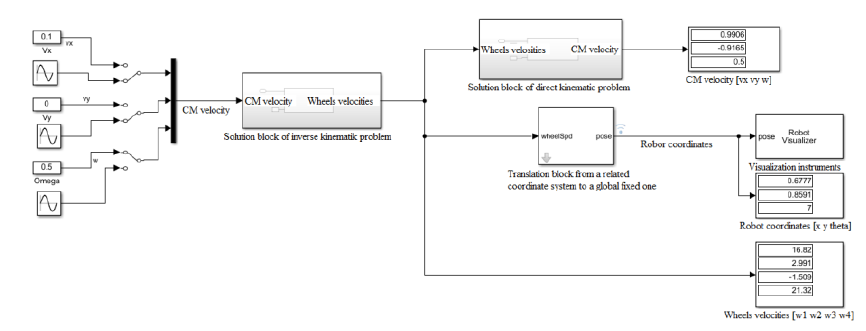
Fig. 11. Debugging mathematical model of robot kinematics